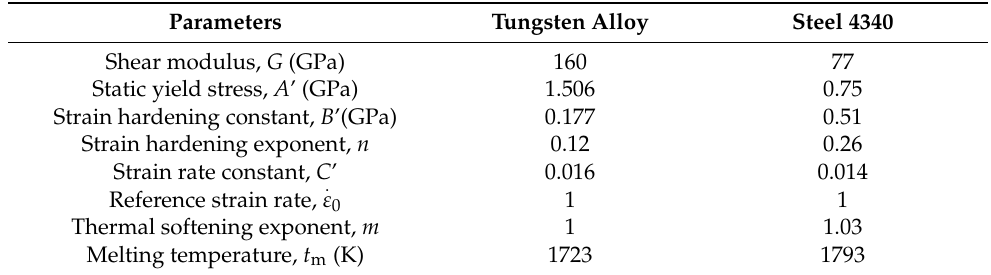
Table 2. Johnson–Cook (JC) strength model constants for the tungsten alloy [29] and steel 4340 [30].